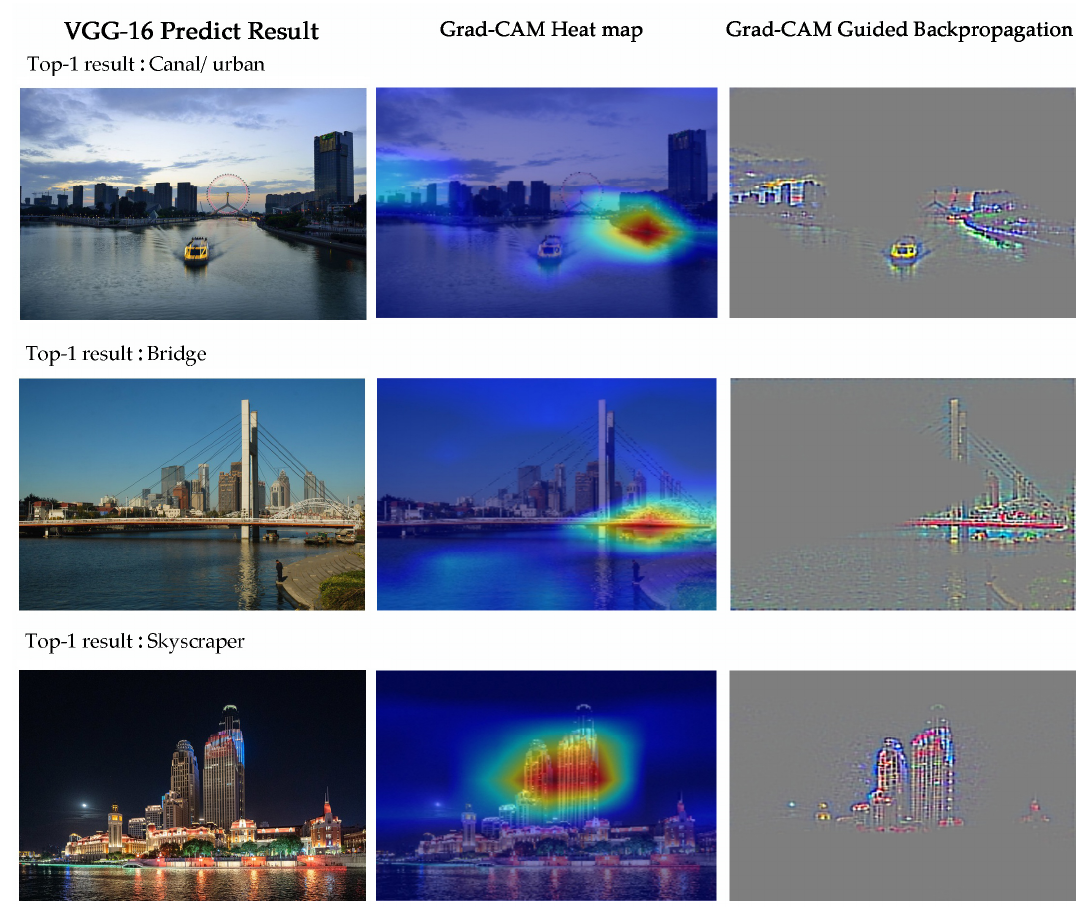
Figure 8. Grad-CAM visualization of the Flickr images. In general, after counting the top-1 prediction results (prediction correct), the most images were in the skyscraper (321), bridge (299), promenade (155), canal/urban (120), downtown (107), harbor (66), tower (64), mosque/outdoor (61), and ice floe (35) categories (Figure 9). The prediction results are consistent with the conjecture results before the deep learning classification experiment. The skyscrapers in the central core area of the Haihe River and the 30 bridges on the Haihe River were the most popular subjects of urban public space imagery. Skyscrapers are mainly concentrated on the south side of Tianjin Station and both sides of Haihe Culture Square, while bridges are evenly distributed at the intersections of main roads with the Haihe River. Among the results, the predictions for the tower and mosque/outdoor scenes were surprising. After we sorted the data, we found that most of the images categorized as mosque/outdoor from the original Flickr images were facades of Tianjin Station and the tower classified was the clock tower of Jinwan Plaza. Figure 10 shows the predicted results from top-1 to top-5, which means that each image has five classification labels: the most numerous image categories are skyscraper (747), downtown (700), bridge (624), tower (531), harbor (456), river (450), promenade (425), office_building (376), and canal/urban (334). The top-5 results are more consistent with the top-1 results. The scenes of downtown, tower, river, etc. are highly similar to the labels of skyscrapers and canal. Overall, the top-1 prediction results are reliable. The image classification led to the following conclusions: the high-rise buildings in the core area of the Haihe River, the bridges, and the promenades along the canal are the most interesting to the public.